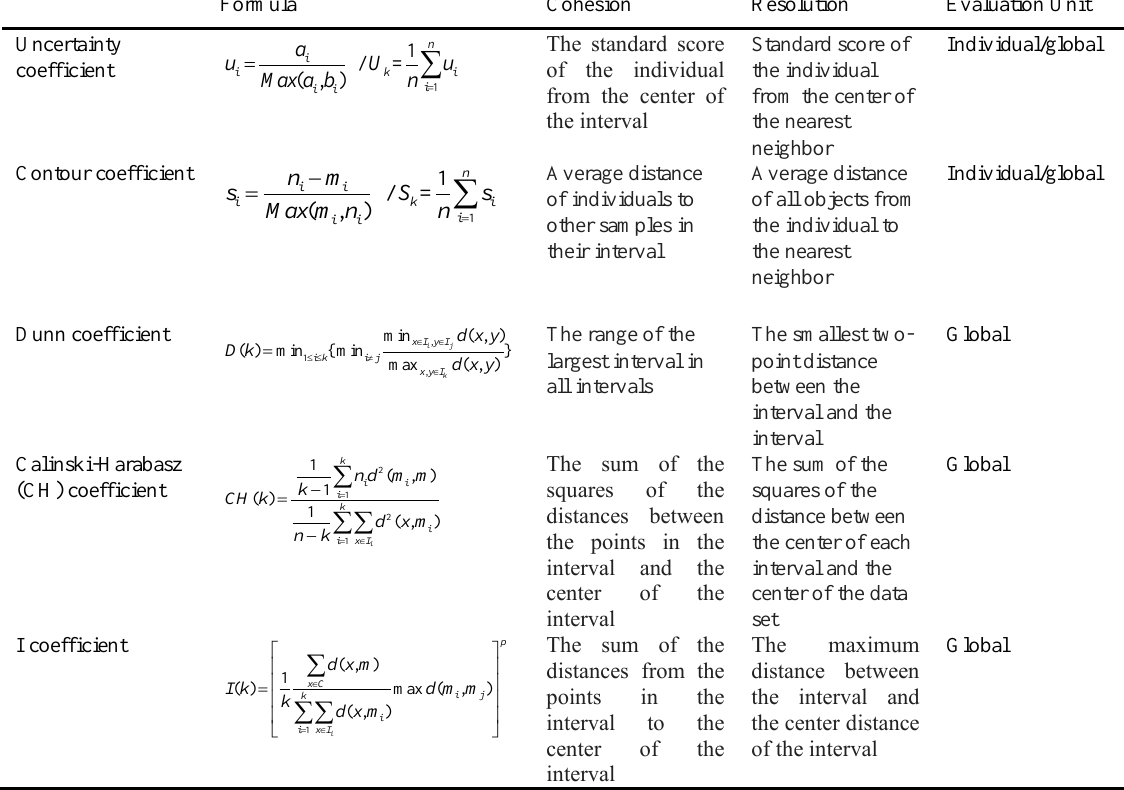
Table 1. Comparison of discretization evaluation coefficient